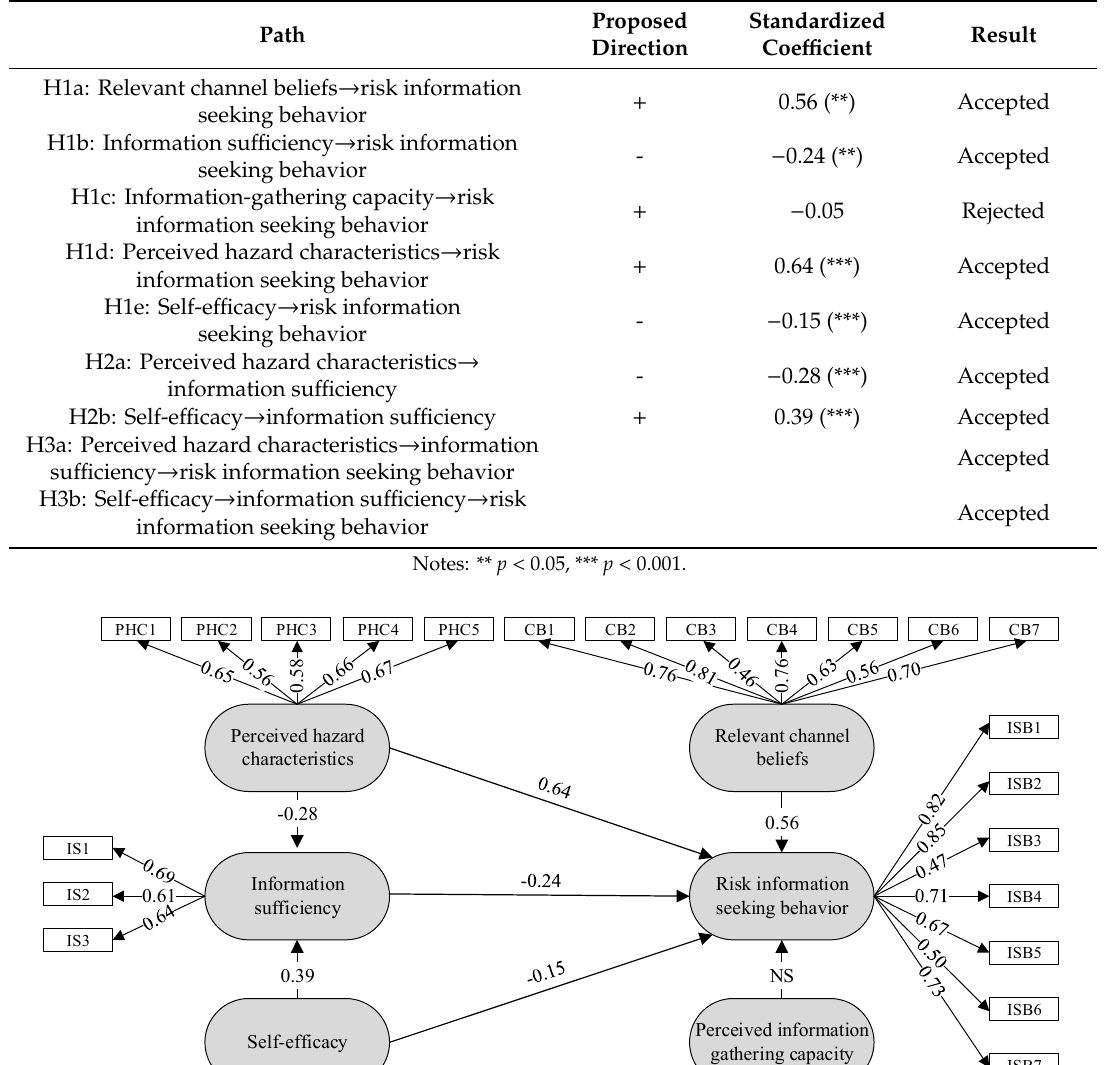
Table 5. Results of the hypothesis testing.